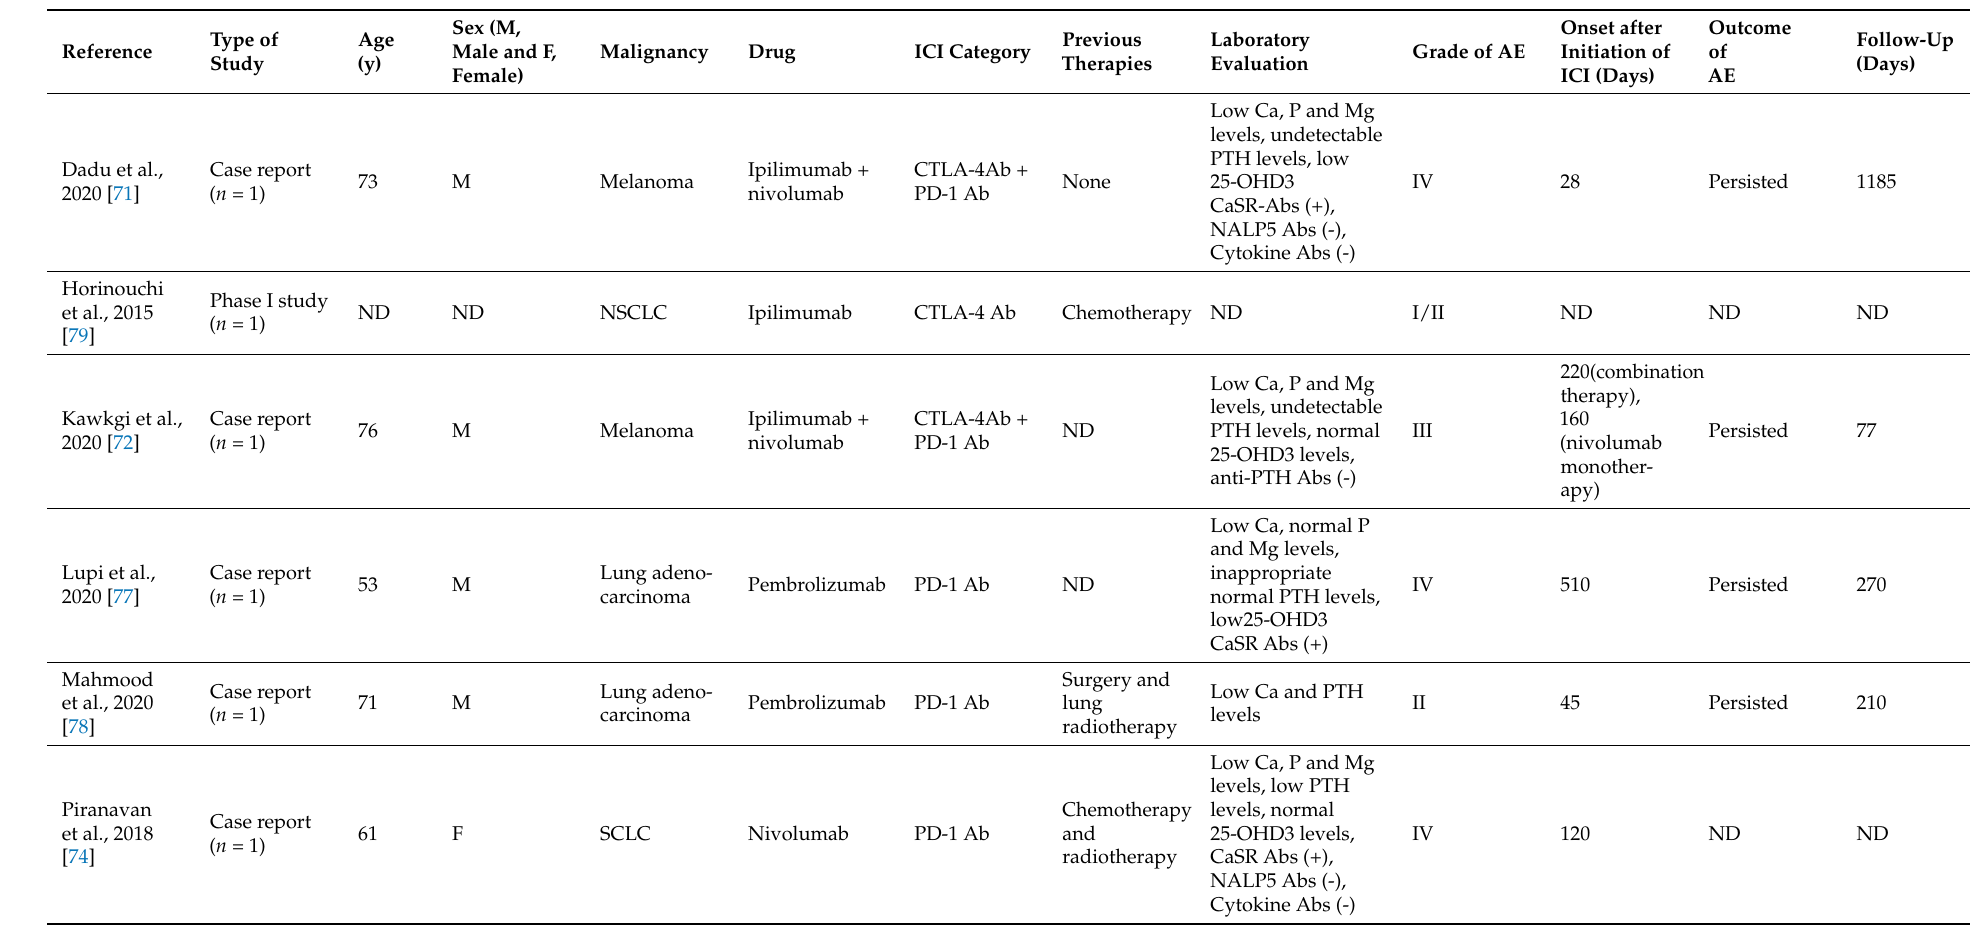
Table 3. Cases in the literature presenting with ICI-induced